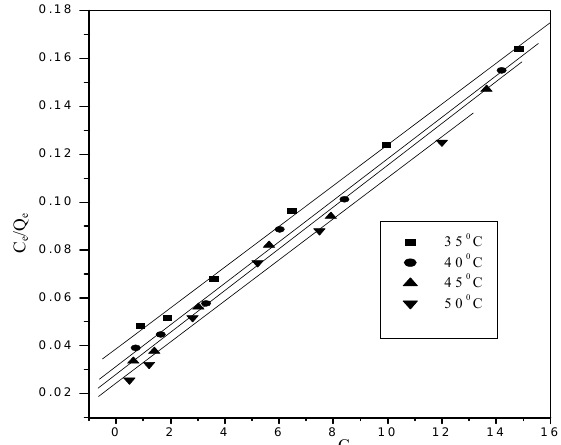
Figure 3. Liner Langmiur adsorption isotherm for copper ion